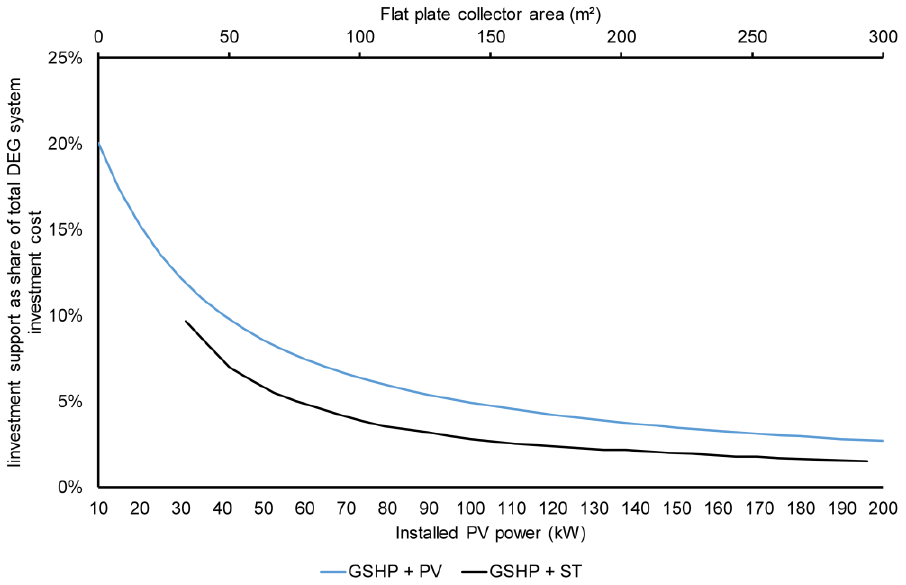
Figure 10. Investment support as share of total DEG system cost for building heated with GSHP.